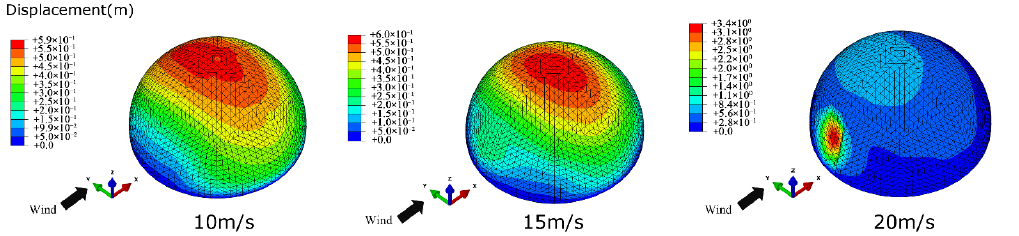
Figure 13. Contours of the maximum displacement under different wind velocities ( L = 60 m, H / L = 0.5, p = 300 Pa).